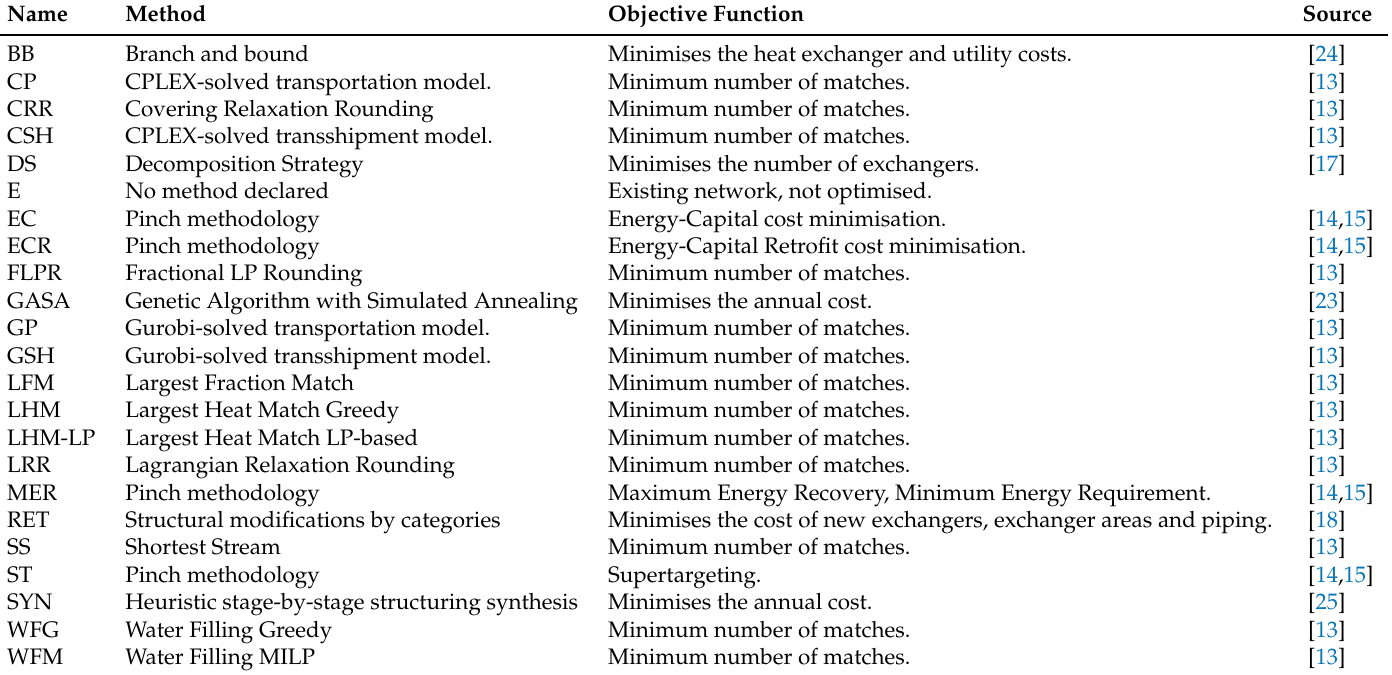
Table 4. Utilised methods and their objective